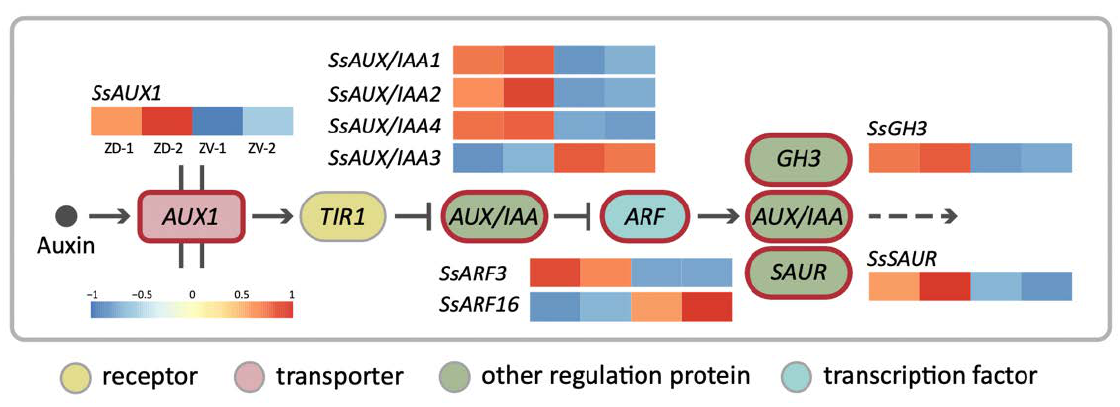
Figure 4. The simplified auxin signaling transduction pathway for the DV–DEGs involved in asymmetric dorsal–ventral petal growth of S. speciosa ‘ES’. Heatmaps represent the degree of dorsal–ventral expression differences. Colors from red to blue represent high to low expression levels.